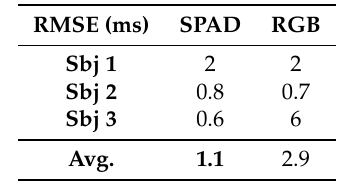
Table 7. Mean square error between tachogram extracted from cameras and ECG. Bold values represent best results.